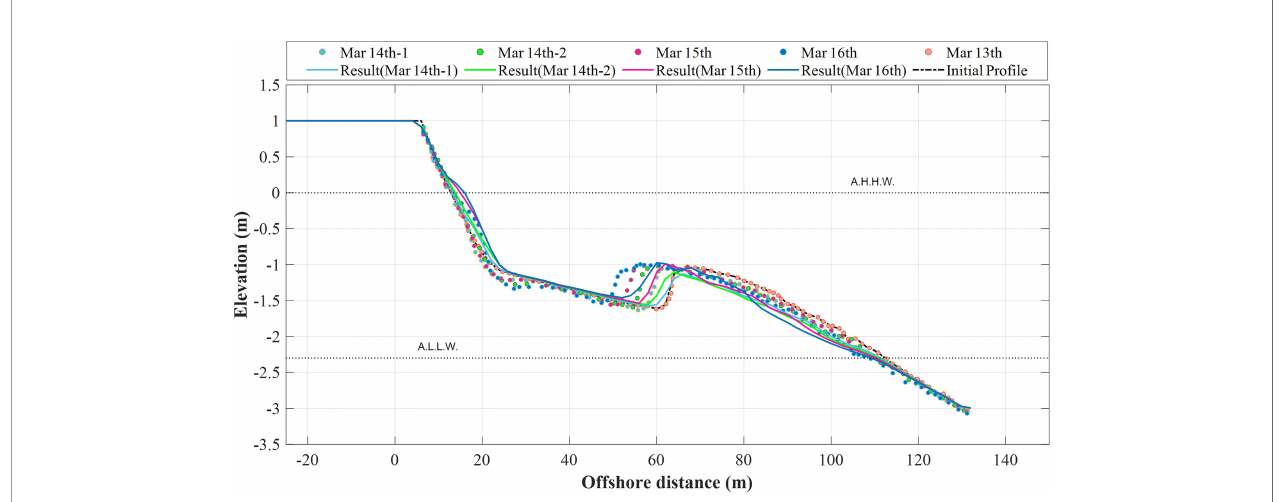
FIGURE 13 | Observed data (symbols) and model (solid line) of beach pro fi le versus cross-shore